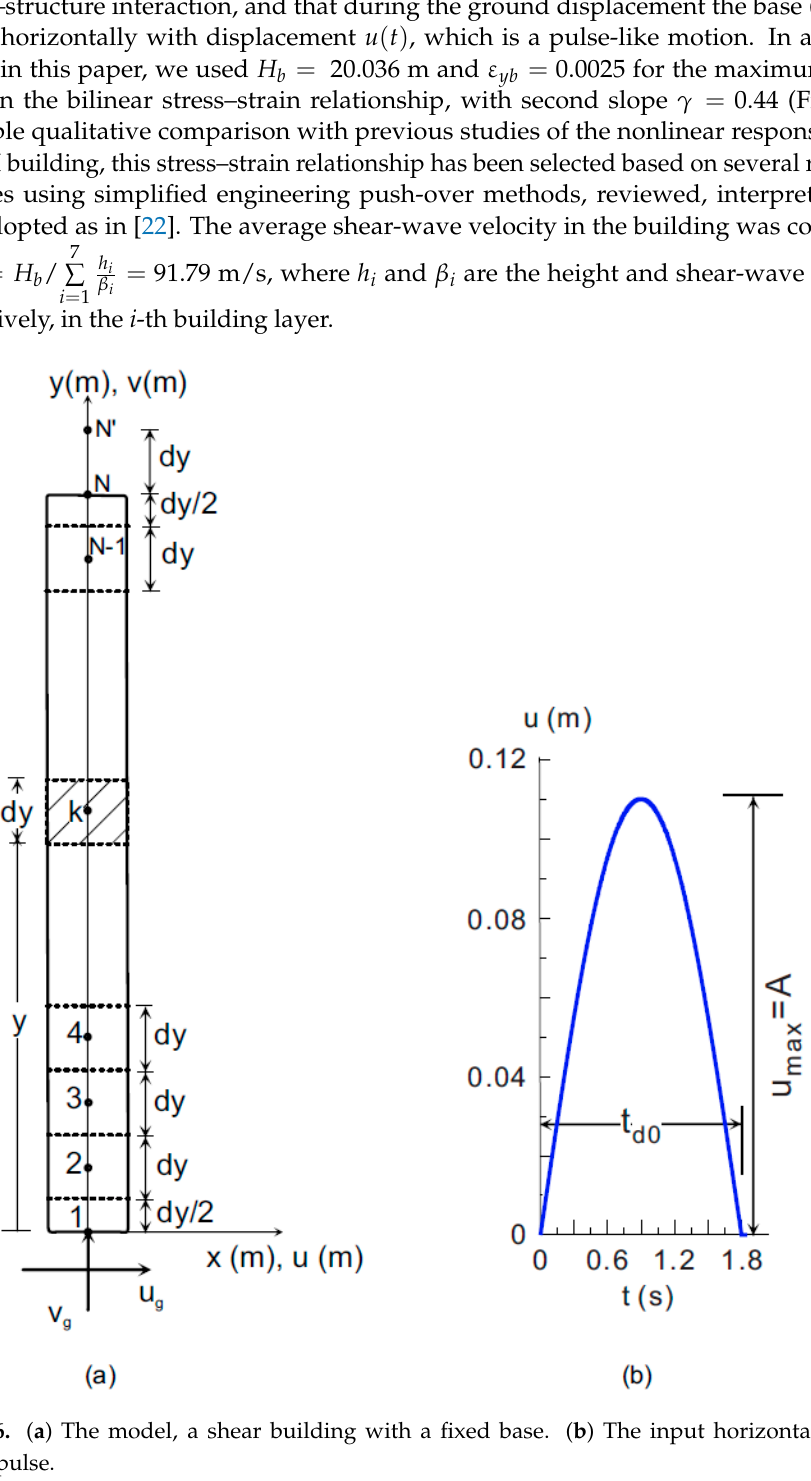
Table 1. One dimensional VN7SH model assumed to be fixed at its base. Story Height (m)